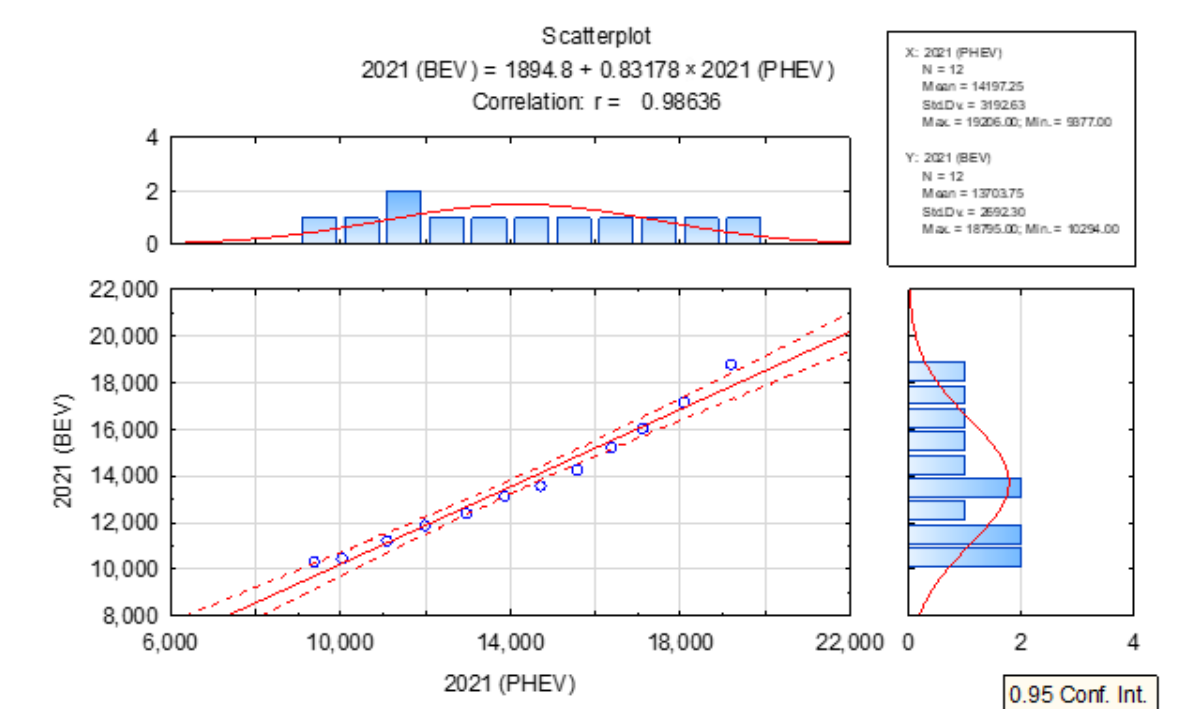
Figure 8. Scatterplot—linear correlation between the number of BEV and PHEV vehicles on the market in Poland in 2021.